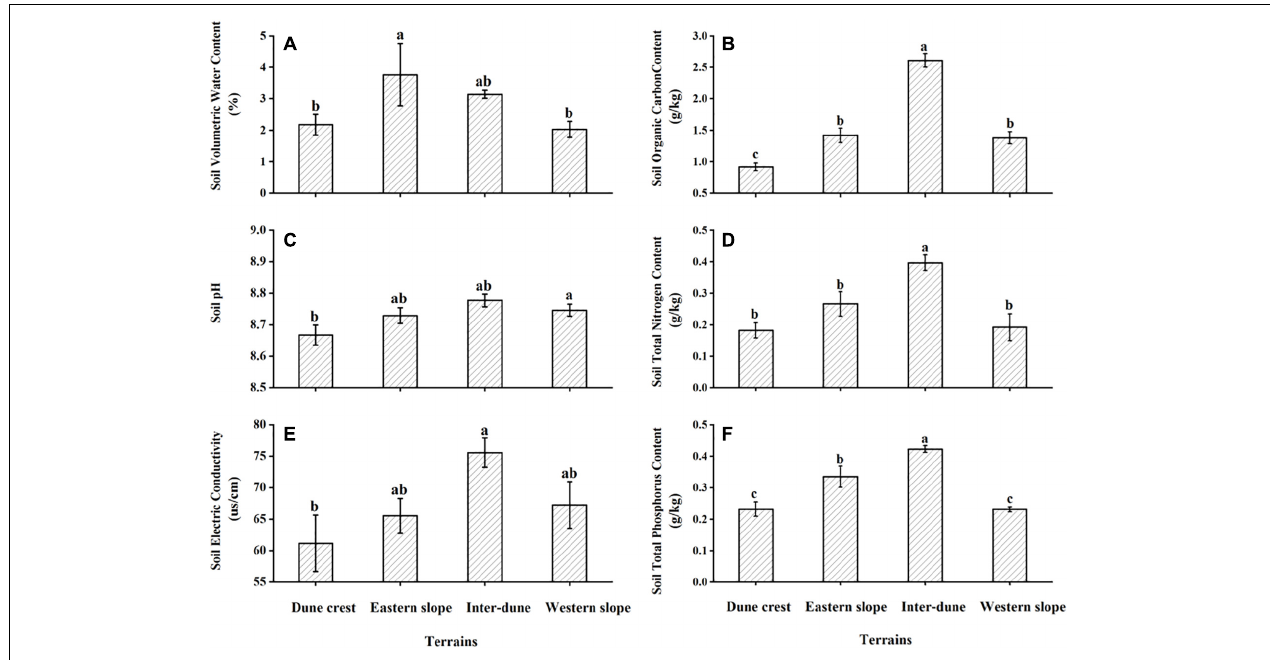
FIGURE 2 | Soil physical (A) and chemical properties (B–F) of different terrains. Different letters represent significant differences ( p < 0.05). Data are presented as the mean ± 1 standard